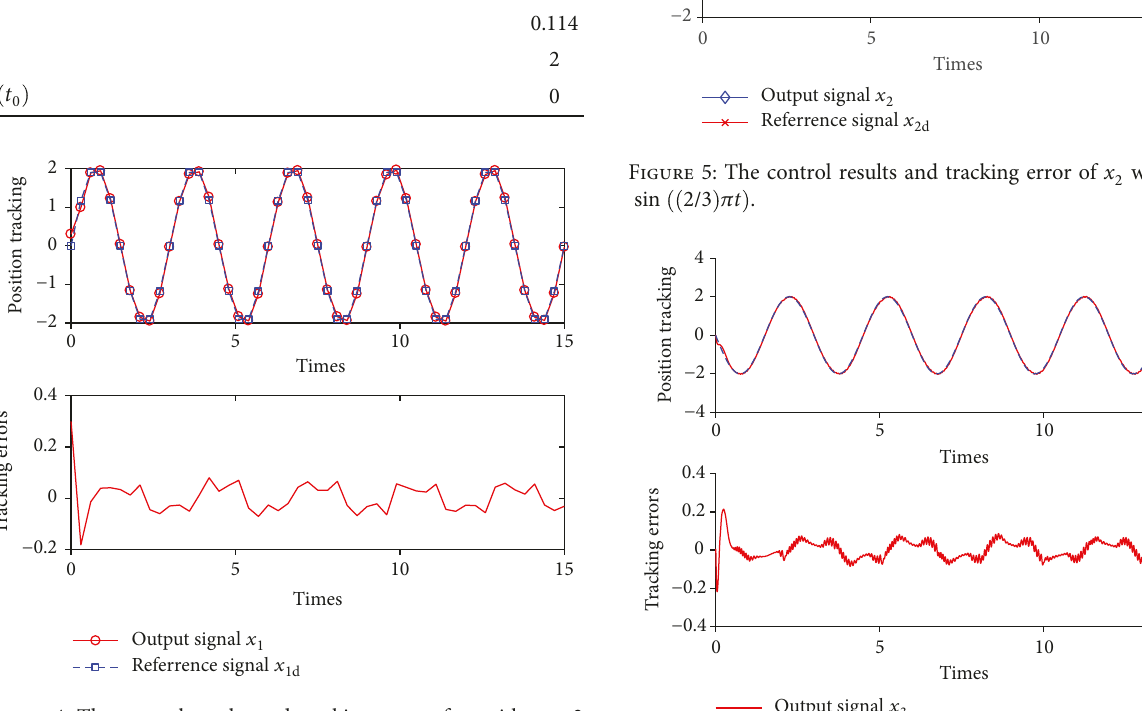
with y = 2 1 d Figure 6: The control results and tracking error of x sin 2/3 π t